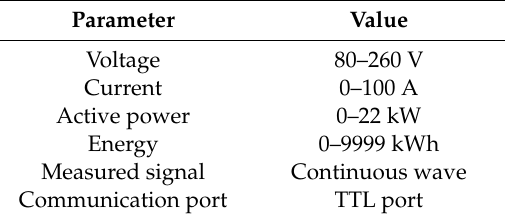
Table 2. Peacefair PZEM characteristics